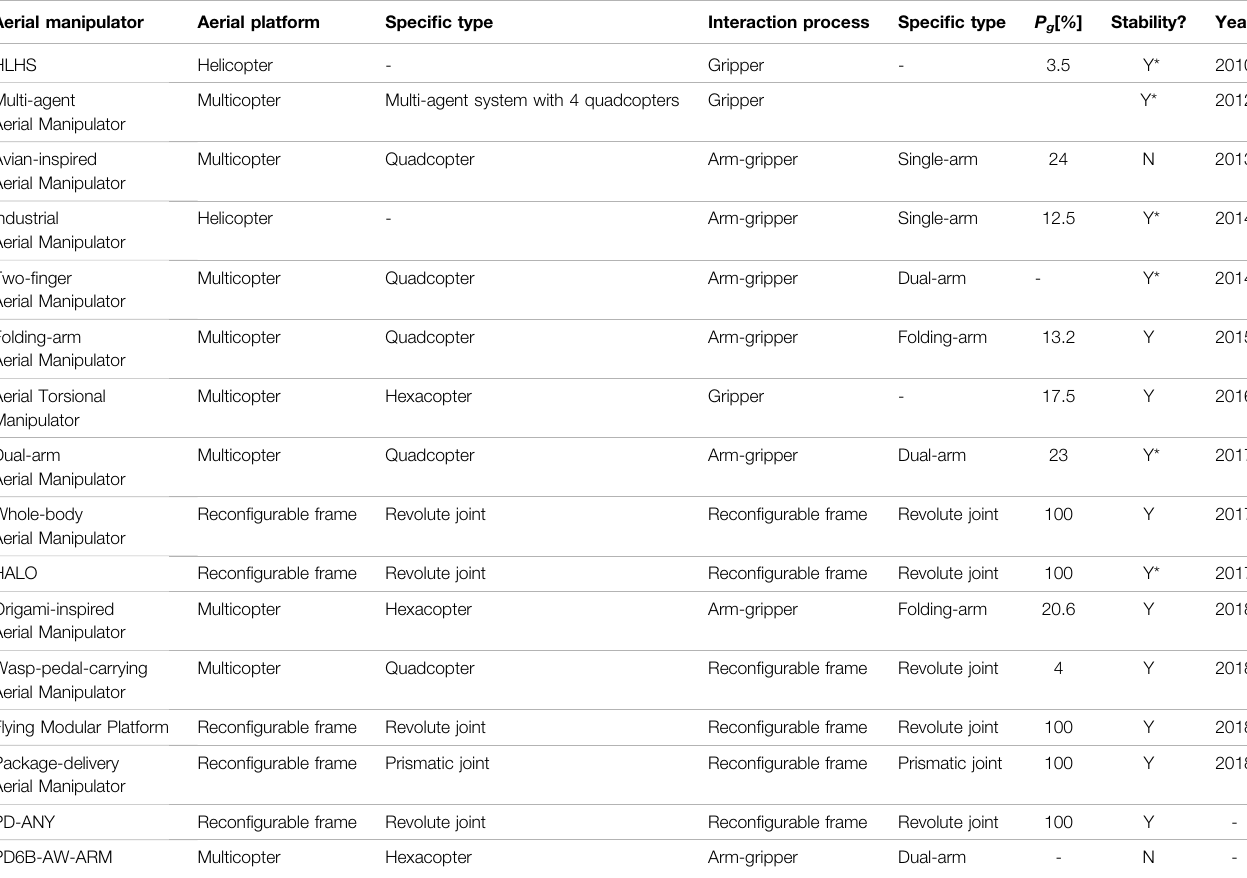
TABLE 3 | Comparison of characteristics of the examined aerial manipulators for aerial grasping. Aerial